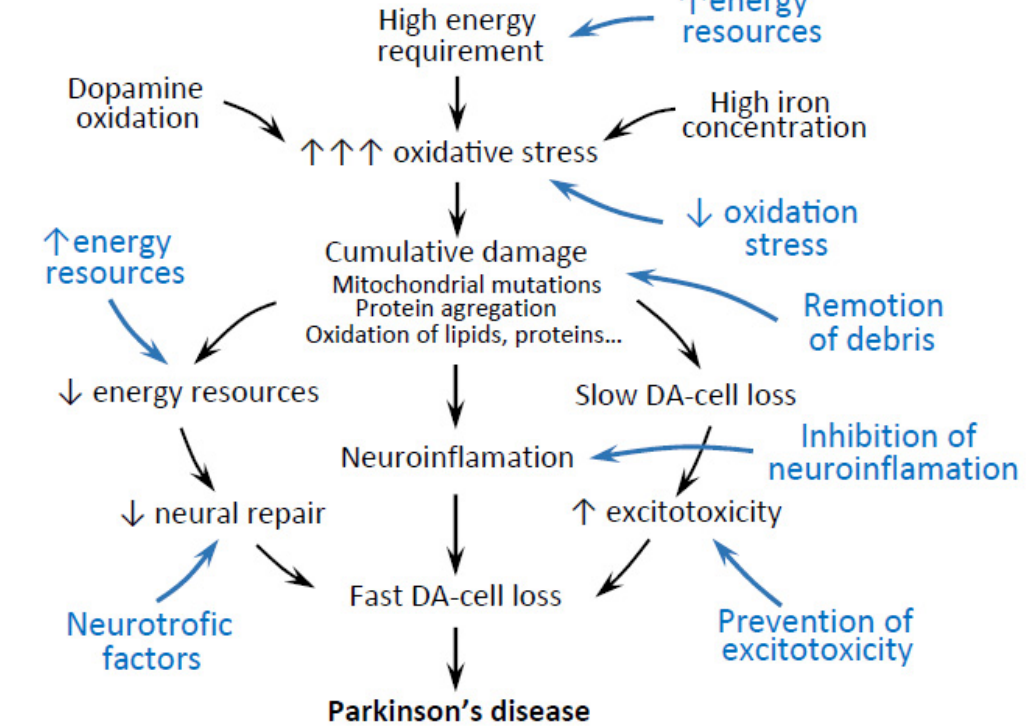
Figure 1. Etio-pathological factors (black) for DA-cell degeneration in PD and neuroprotective activities of astrocytes (blue). Table 1. Acting on the different stages of the PD evolution.